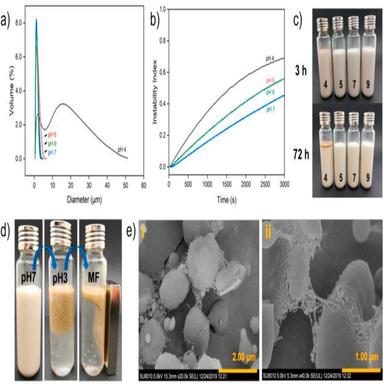
Effect of MCNC pH on properties of MCNC-PE. a) Particle size distribution; b) Instability index and c) Visual images of MCNC-PE stabilized by MCNC at pH 4, pH 5, pH 7 and pH 9; d) The visual images of pH/magnetic response of MCNC-PE and e) Cryo-SEM images of MCNC-PE, scale bars = 2.00 μm, 1.00 μm, respectively. Note: pH 5 curve was hidden under the pH 9 curve in 5b. MCNC, magnetic cellulose nanocrystals; MCNC-PE, magnetic cellulose nanocrystals stabilized Pickering emulsion; MF, magnetic field.